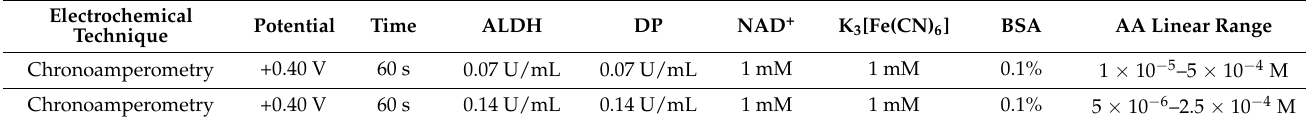
Table 1. Experimental conditions for the electrochemical detection of acetaldehyde.